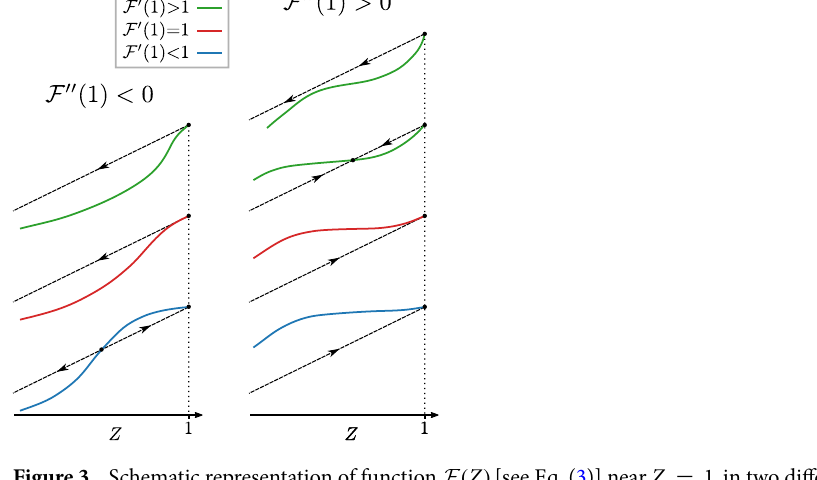
Figure 3. Schematic representation of function F ( Z ) [see Eq. (3)] near Z depending on the sign of the second derivative F ′′ ( 1 ) at the critical point: F ′′ ( 1 ) < 0 on the left and F ′′ ( 1 ) > 0 on the right. The arrows show the effect of a small perturbation to the fixed